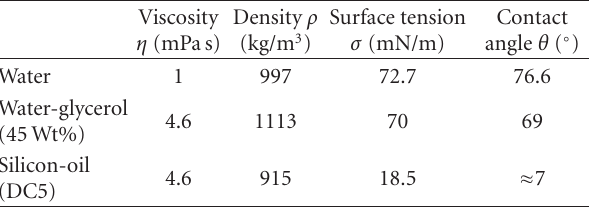
Table 4: Properties of the testing system.